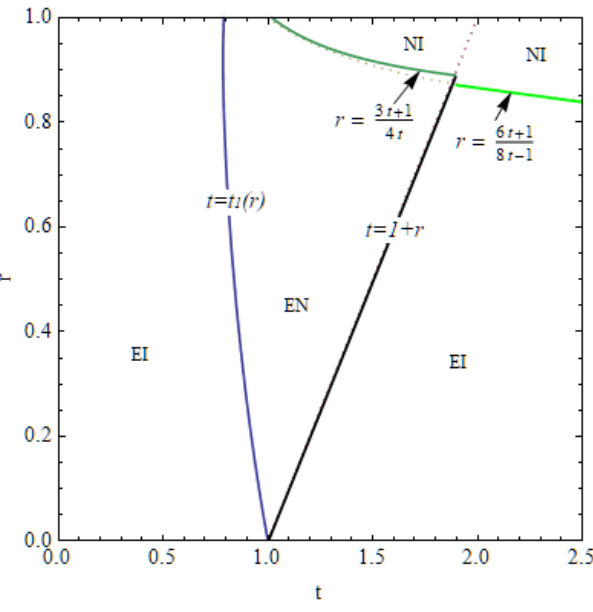
Fig. 2. The equilibrium outcome of the whole